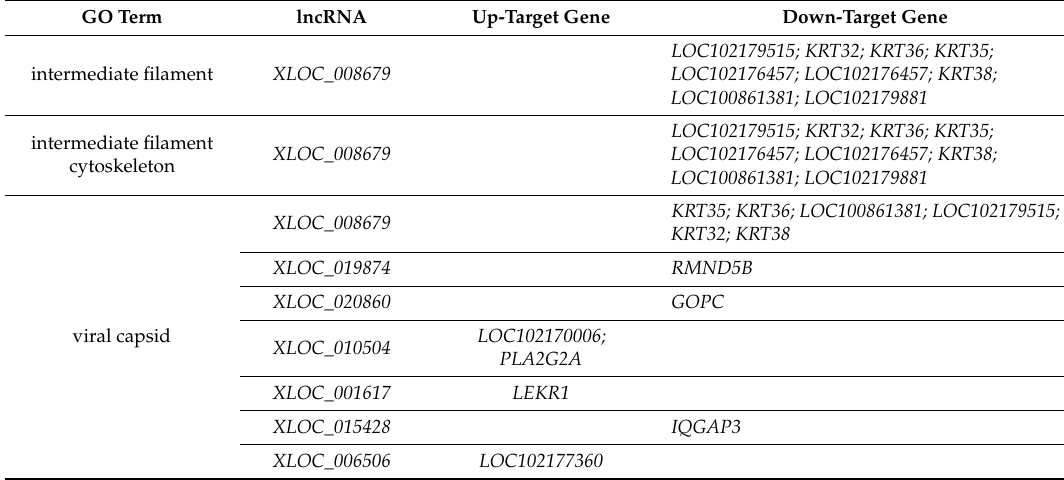
Table 4. Gene ontology (GO) term of cashmere